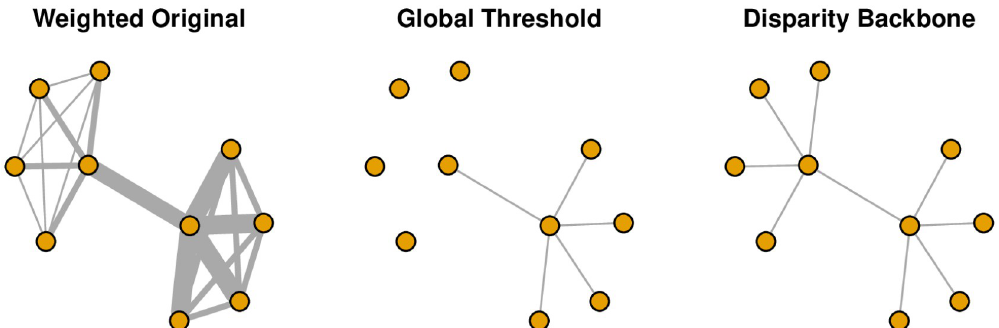
Fig 2. Extracting the backbone of a weighted network (toy